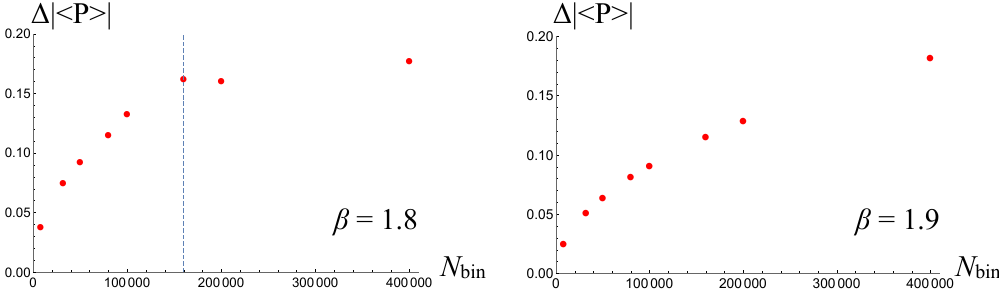
Figure 12 . Bin-size dependence of errors of absolute values of the Polyakov-loop expectation values for N = 3 and (cid:12) = 1 : 8 ; 1 : 9 with ( N s ; N (cid:28) ) = (200 ; 8) in Z N -TBC. The horizontal axis is N bin and the vertical axis is an error of jh P ij .